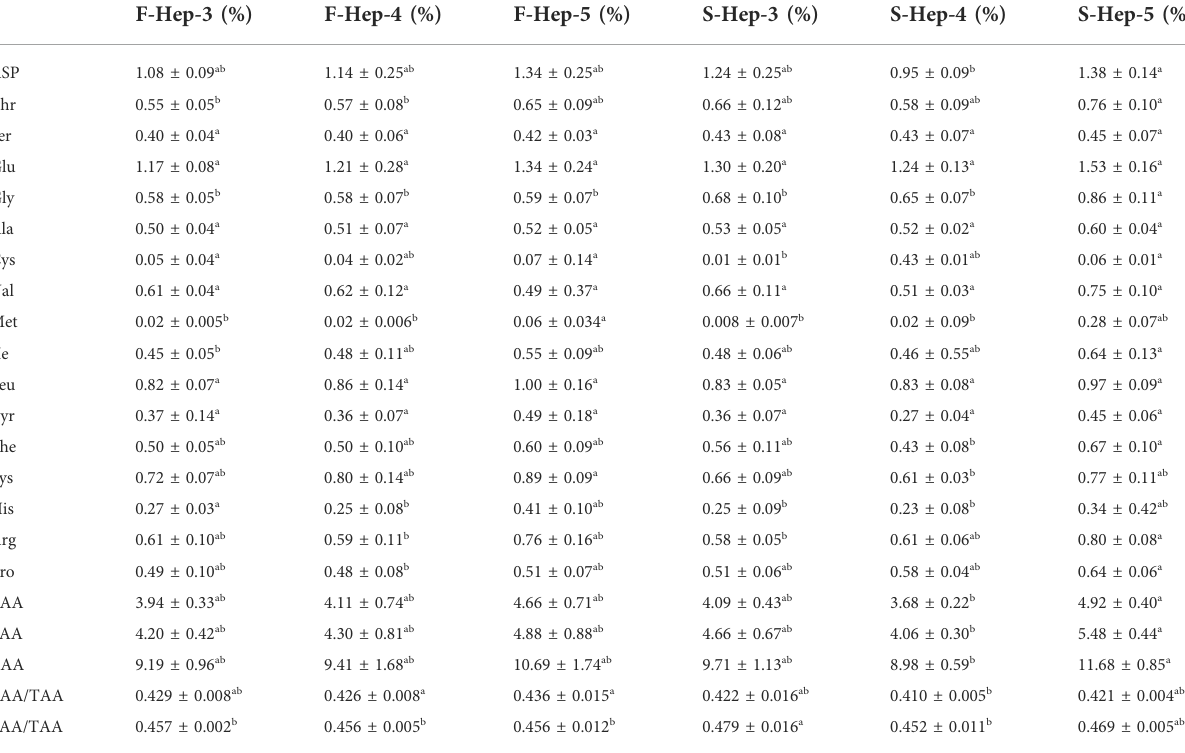
TABLE 6 Pro fi le of amino acids in female Scylla paramamosain hepatopancreas during the two vitellogenesis periods. F-Hep-3